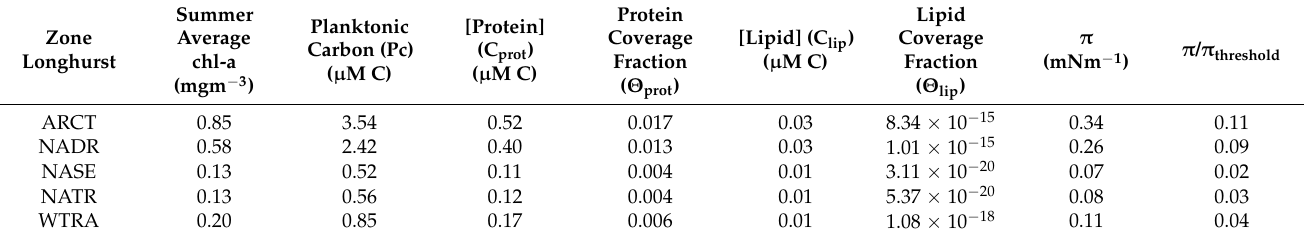
Table 2 . Computing surface pressure from chl-a in the North Atlantic ecological regions assuming a threshold surface pressure(π thresh ) of 3 mNm − 1 .